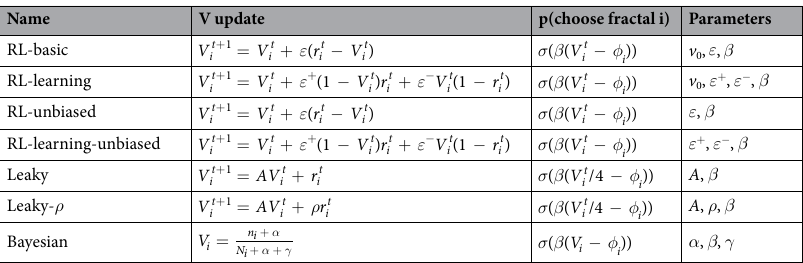
Table 2. Model specification. The second column shows how internal values for a fractal i are updated after observing an outcome r in trial t . The Bayesian model does not model learning on a trial-by-trial basis. The third column depicts the choice rule that is used to calculate the probability of choosing the fractal over the alternative option (Equation 3). The initial value is set to zero or modelled by v 0 . φ i is the displayed probability when asked to make a choice for fractal i . ε is the learning rate; β is the inverse temperature parameter; A is the memory parameter; ρ is the reward sensitivity parameter; α and γ are the parameters of the Beta prior. N i and n i are the number of times a fractal i was observed and followed by reward respectively. See main text and Supplement for additional